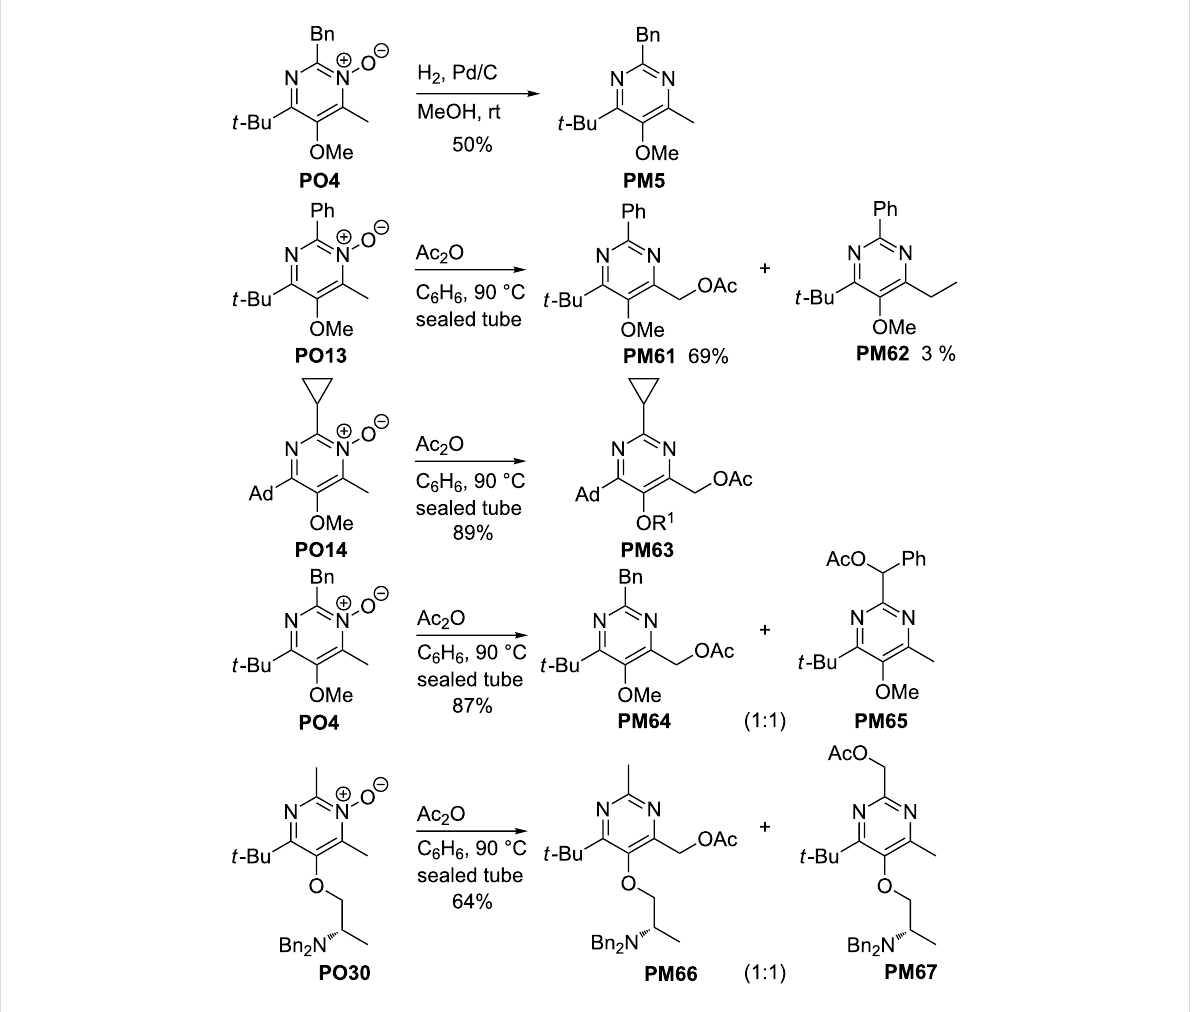
Scheme 19: Reduction of PO4 to PM5 and Boekelheide rearrangements of PO13 , PO14 , PO4 and PO30 to 4-acetoxymethyl-substituted pyrimidine derivatives; Ad = 1-adamantyl.